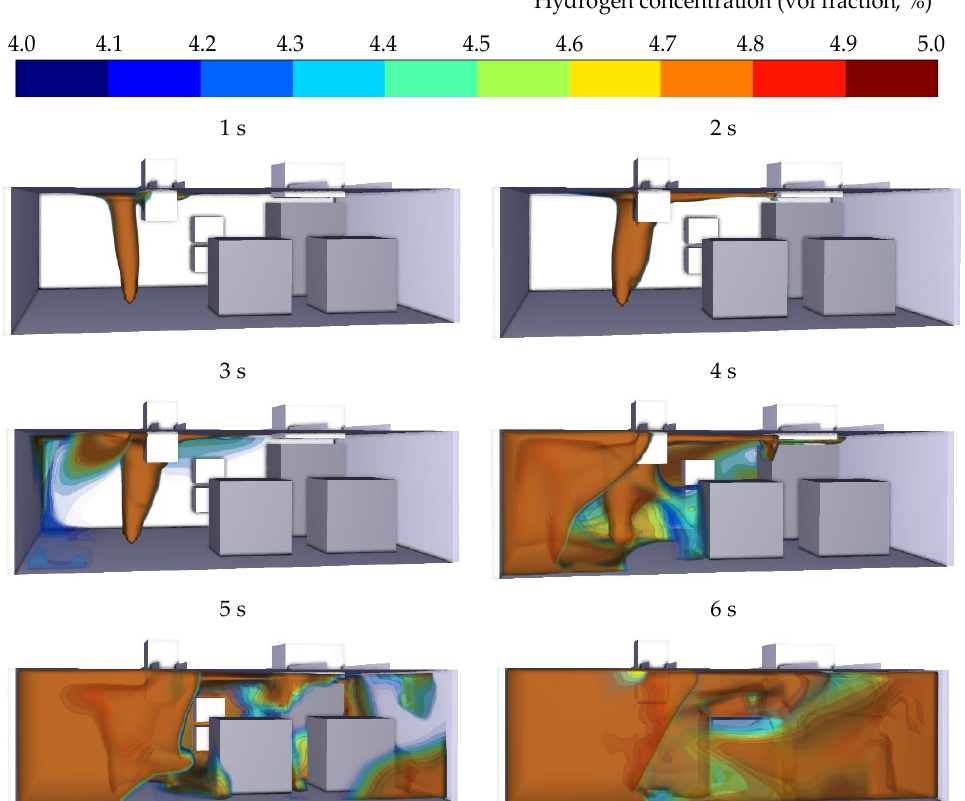
Figure 8. Three-dimensional views of hydrogen gas dispersion in the fuel cell room at different times from 1 s to 6 s. (the times represent the seconds after the start of hydrogen leakage).